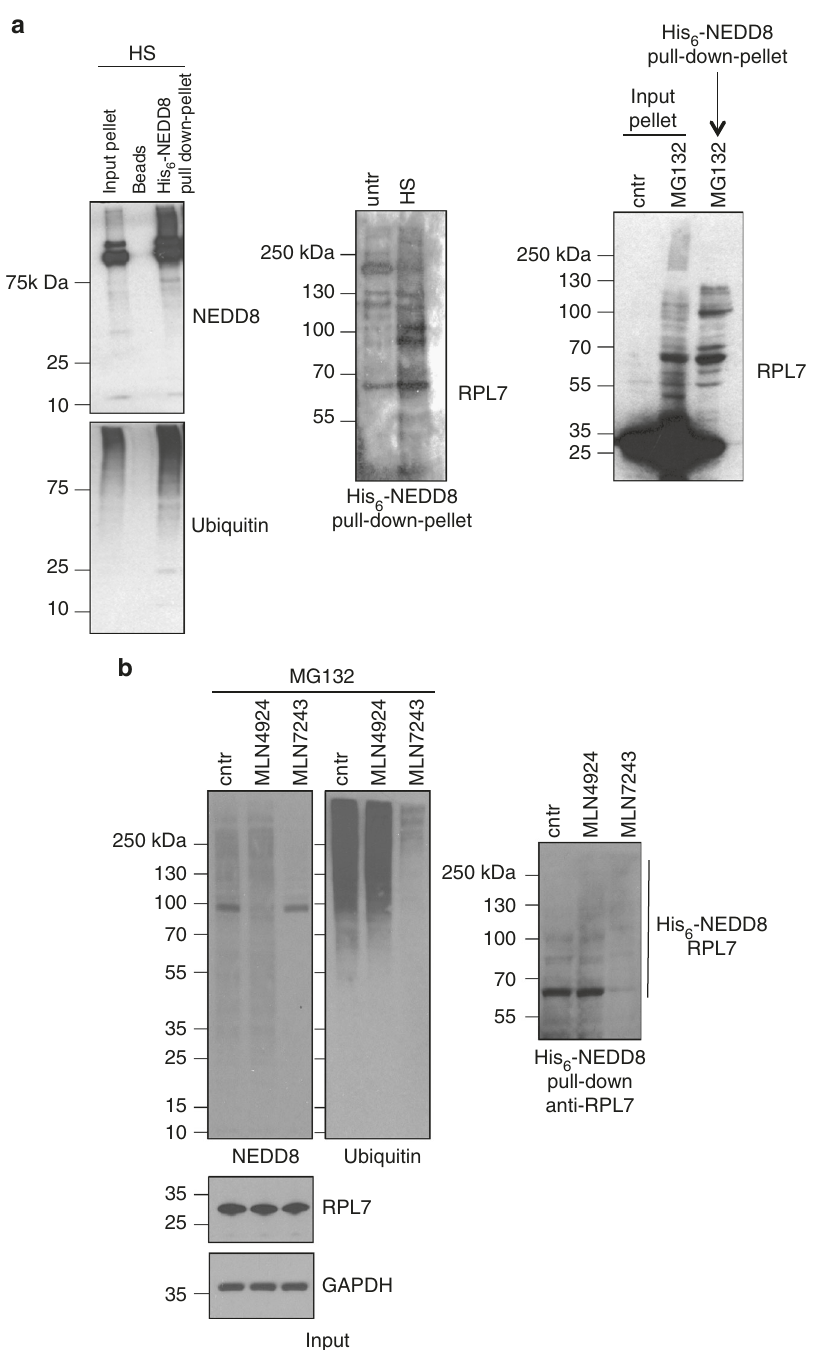
Fig. 4 UBA1-dependent NEDDylation of RPL7 upon proteotoxic stress. a HCT116 cells stably expressing His 6 -NEDD8 were heat-shocked or treated with MG132 (25 µ M, 2 h) and then subjected to a subcellular fractionation. Pellet fractions were solubilized and then NEDDylated substrates were isolated by Ni-NTA pull-down as described in Methods. The isolated NEDDylated substrates were blotted against the indicated proteins. b Experiment was performed as above but cells were pretreated with MLN4924 (500 nM 15 h) and MLN7243 (500 nM, 3 h) before MG132 treatment. Ni-NTA pull-down was performed from total cell extracts and western blot analysis as indicate that the mechanism by which NEDD8 can promote aggregation of misfolded proteins is to prevent their degradation by the proteasome pathway.